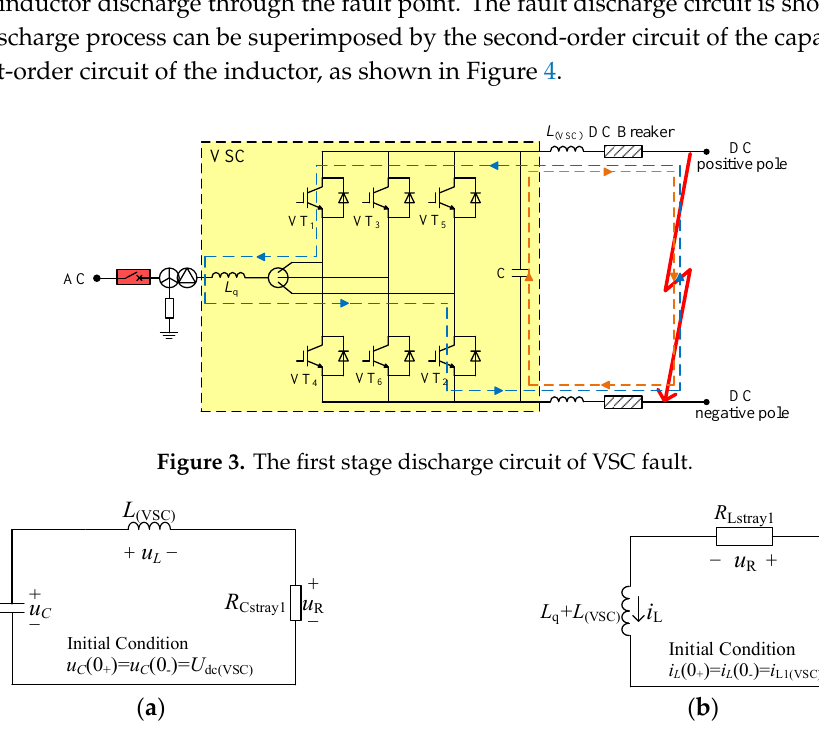
Figure 4. Equivalent circuit of the first stage discharge circuit of VSC: ( a ) capacitor and inductor discharge equivalent circuit and ( b ) inductor discharge equivalent circuit.